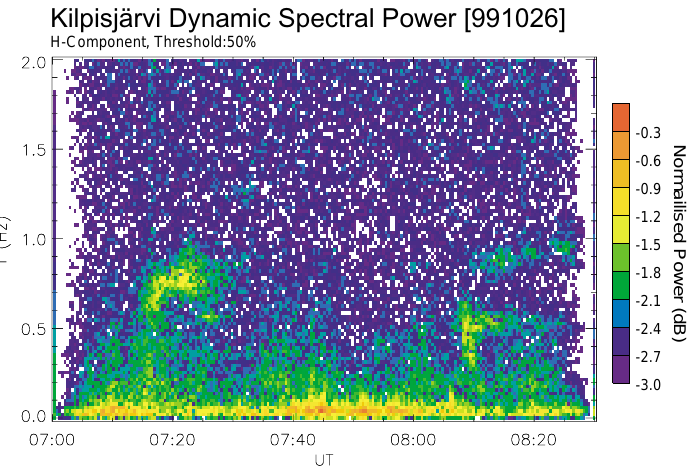
Fig. 6. A dynamic power spectrum de- rived from H -component data recorded by the Kilpisj¨arvi pulsation magne- tometer (KIL) on 26 October 1999. Bursts of Pc1 activity are apparent at frequencies below 1Hz. The data pre- sented here was analysed using a 51.2s spectral window with a slip of